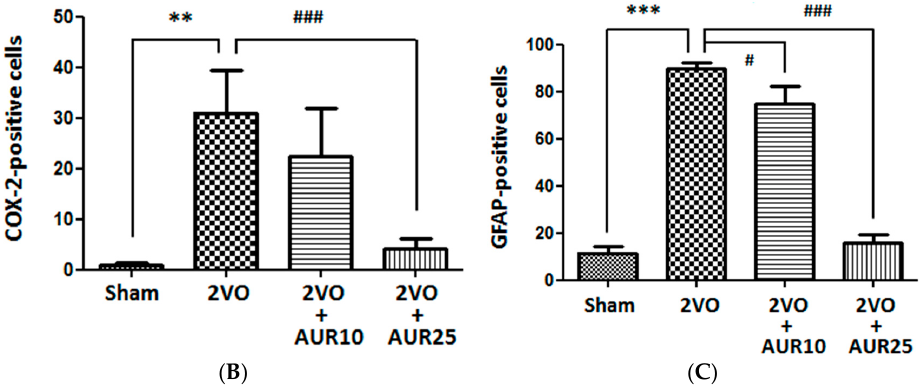
Figure 2. Effects of AUR on the expression of COX-2 and GFAP in the hippocampus. ( A ) Representative photographs of COX-2-positive cells (green; a, d, g, j), GFAP-positive cells (red; b, e, h, k), and cells co-expressing COX-2 and GFAP (yellow; c, f, i, l). The scale bar indicates 100 µm; ( B ) The numbers of COX-2-positive cells; and ( C ) GFAP-positive cells are shown. Values are the means ± SEM (6 sections in each group). ** p < 0.01; *** p < 0.001; # p < 0.05; and ### p < 0.001, as indicated by the brackets.